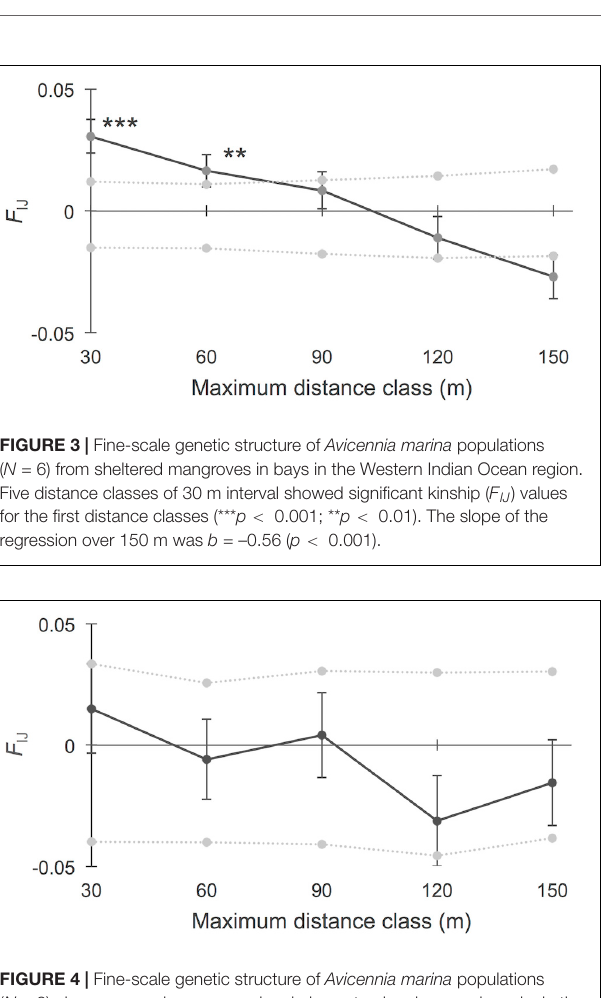
FIGURE 4 | Fine-scale genetic structure of Avicennia marina populations ( N = 8) along exposed mangroves bordering estuarine rivers and creeks in the Western Indian Ocean region. Five distance classes of 30 m interval showed no significant kinship ( F IJ ) values. The slope of the regression over 150 m was b = –0.35